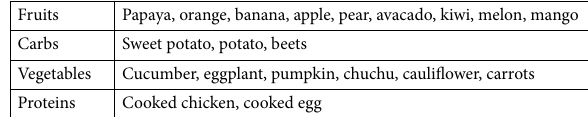
Table 4. Diet collectively fed to marmoset hosts in sampled captive